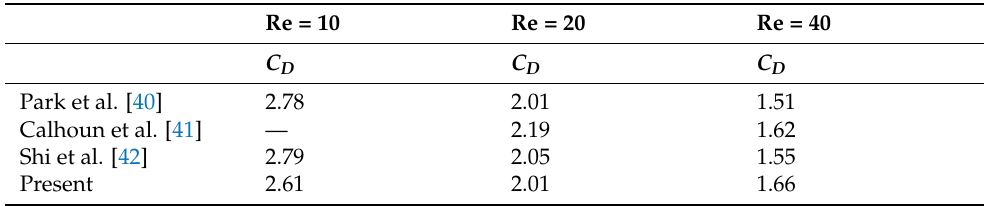
Table 1. The drag coefficients C D obtained on the cylinder and compared with the other literature [40–42] at different Reynolds numbers.